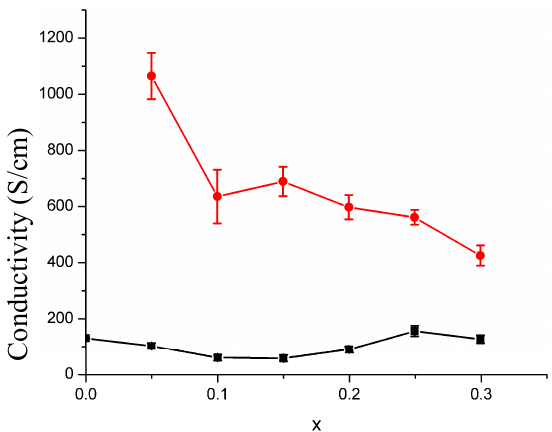
Figure 3. The conductivity of Mg x In 2 − 2x Sn x O 3 before (squares) and after (circles) reduction. Error bars may be hidden by the data points. The point at x = 0 (pure In 2 O 3 ) is reproduced from Reference [27], which follows a similar sample preparation.